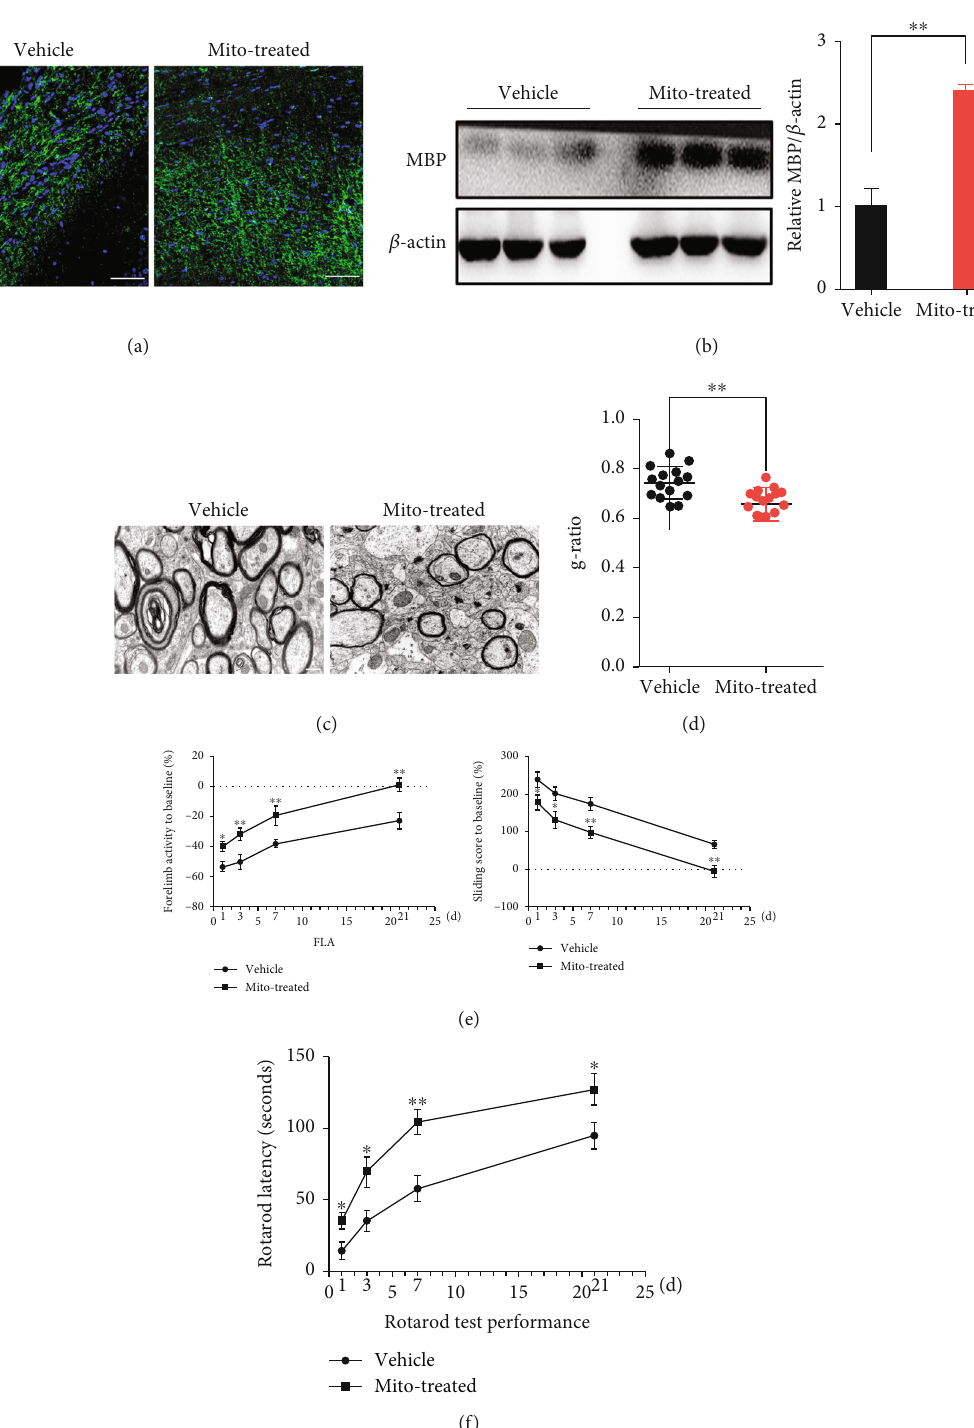
Figure 4: E ff ects of grafted mitochondria on myelination and locomotion recovery. (a, b) Immunostaining and Western blotting of MBP in control and mitochondria-treated mice at 3w posttransplantation. Notice the higher levels of MBP expression in mitochondria-treated mice. (c, d) Representative EM images of myelin in control and mitochondria-treated mice at 3w posttransplantation and g -ratio of myelin. Notice the loose and degenerating myelin in control group and the compact and morphologically normal myelin in mitochondria- treated group. (e) Forelimb activity (glass sliding) assay. (f) Rotarod assay. Notice the better locomotion recovery in mitochondria- treated mice. Student ’ s t test for (b, d). One-way ANOVA for (e, f). N = 3 mice per group in (a – d). N = 10 mice per group in (e, f). ∗ P < 0 : 05 . ∗∗ P < 0 : 01 . Bars = 50 μ m in (a, b) and 500nm in